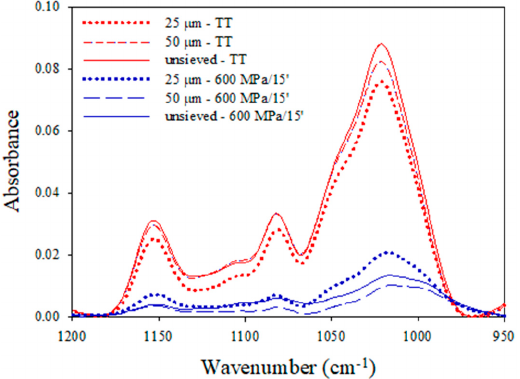
Figure 2. FT-IR spectra of potato starch suspensions (20% w / w) of di ff erent particle sizes treated by high pressure (600 MPa for 15 min at 25 ◦ C) and thermal